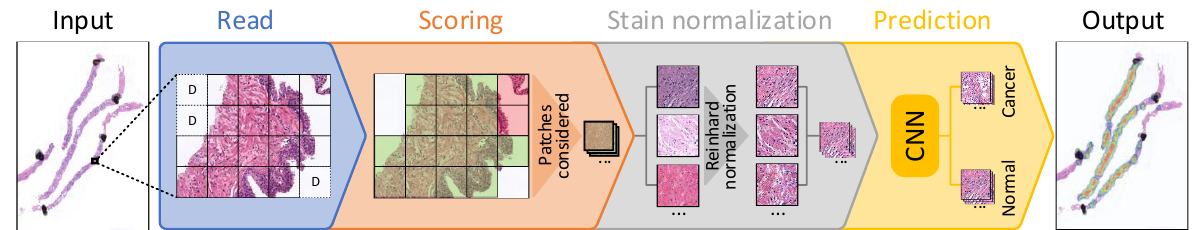
Figure 1. Block diagram detailing each of the steps considered for processing a whole-slide image (WSI) in the pro- posed